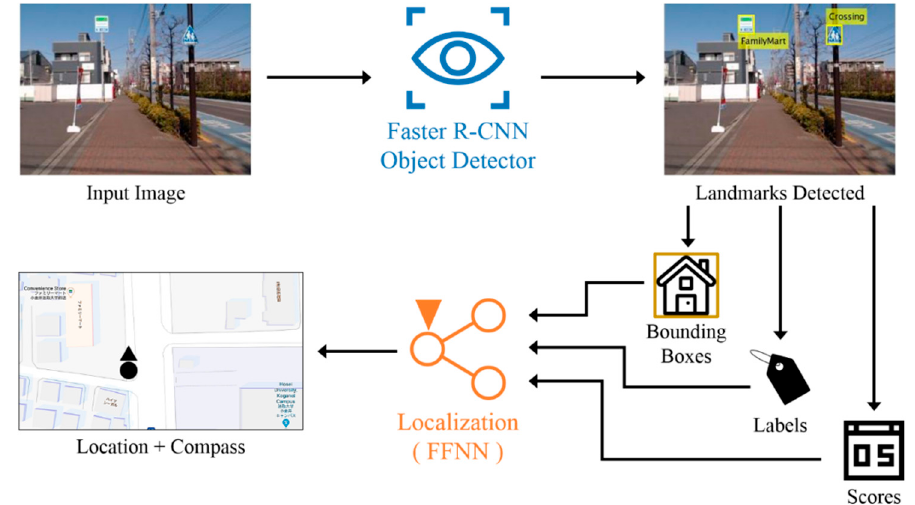
Figure 1. System flows of the Faster Regional-Convolutional Neural Network (Faster R-CNN) based localization method.